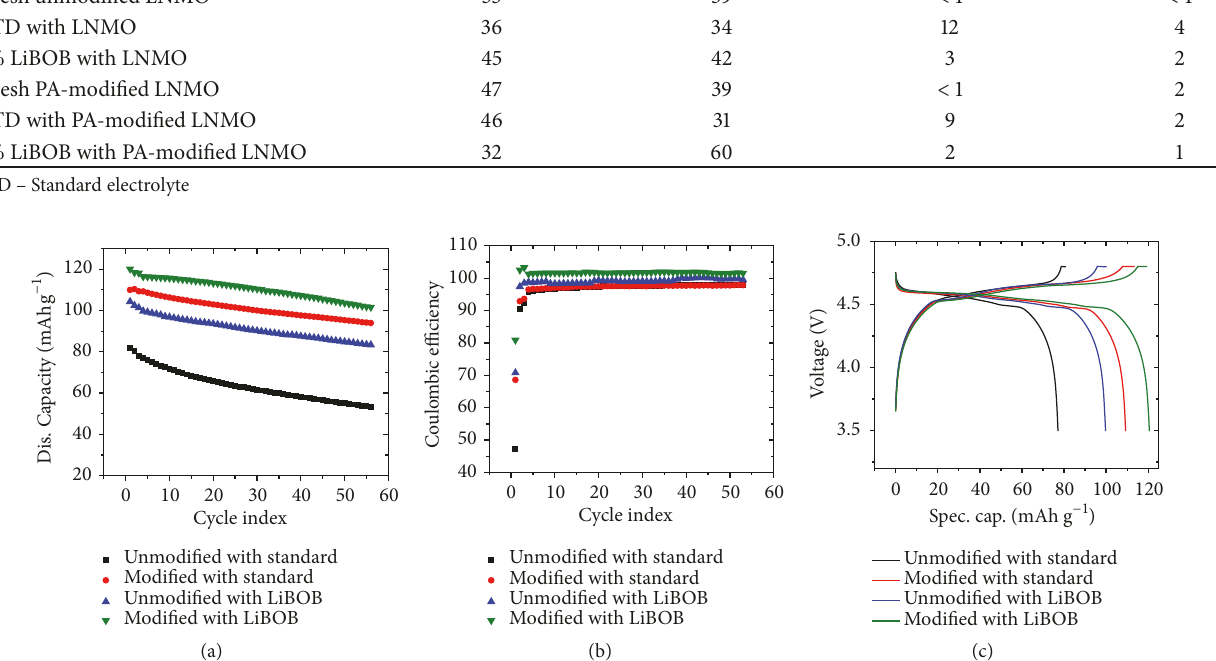
Figure 1: Comparison of (a) discharging capacities (based on the cathode active material), (b) coulombic efficiencies, and (c) 4th cycle charge/discharge curves of phosphoric acid modified and unmodified LNMO/graphite full cells with and without LiBOB in 1.0 M LiPF 6 EC/EMC 3/7